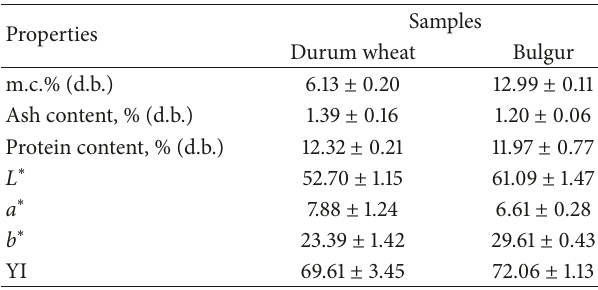
Table 1: Physical and chemical properties of Durum wheat and